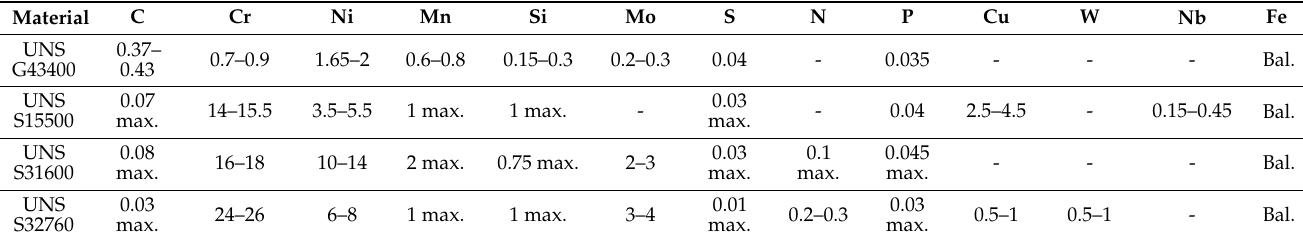
Table 1. Nominal chemical compositions (wt%) of the tested materials.